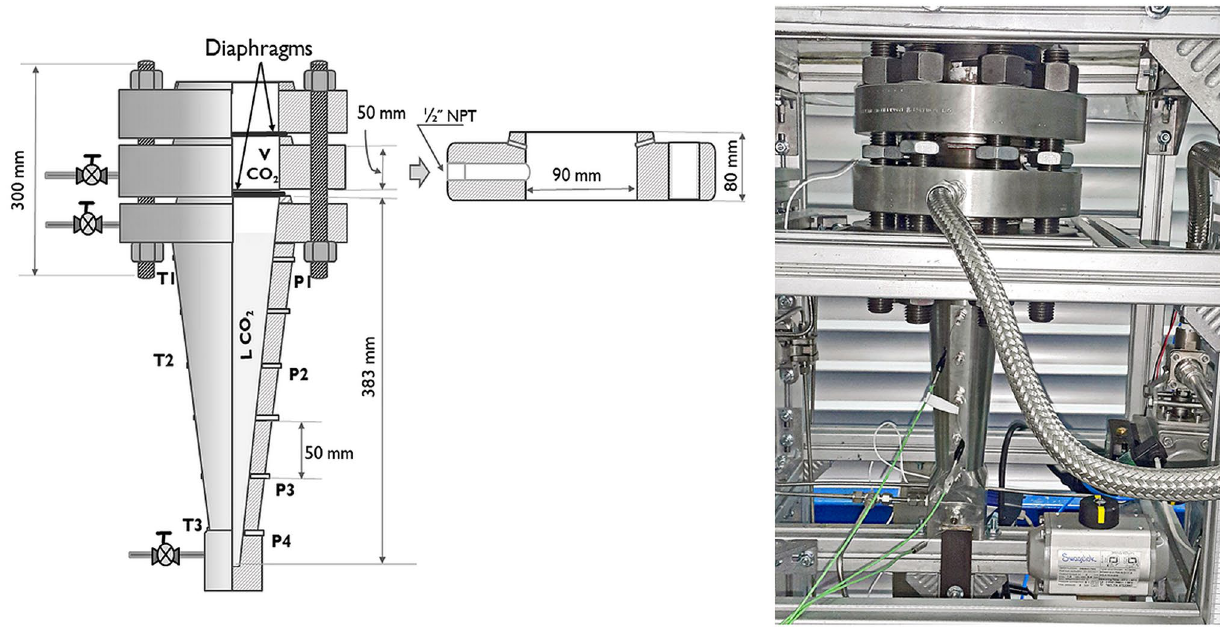
Fig. 1 Schematic drawing of the double-diaphragm conical arrangement, its main dimensions, and a magnified MPS sketch on the left- hand side. An image of the conical vessel fastened with the two flanges on the right-hand